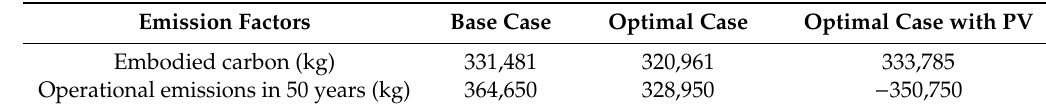
Table 14. The embodied carbon and operational carbon